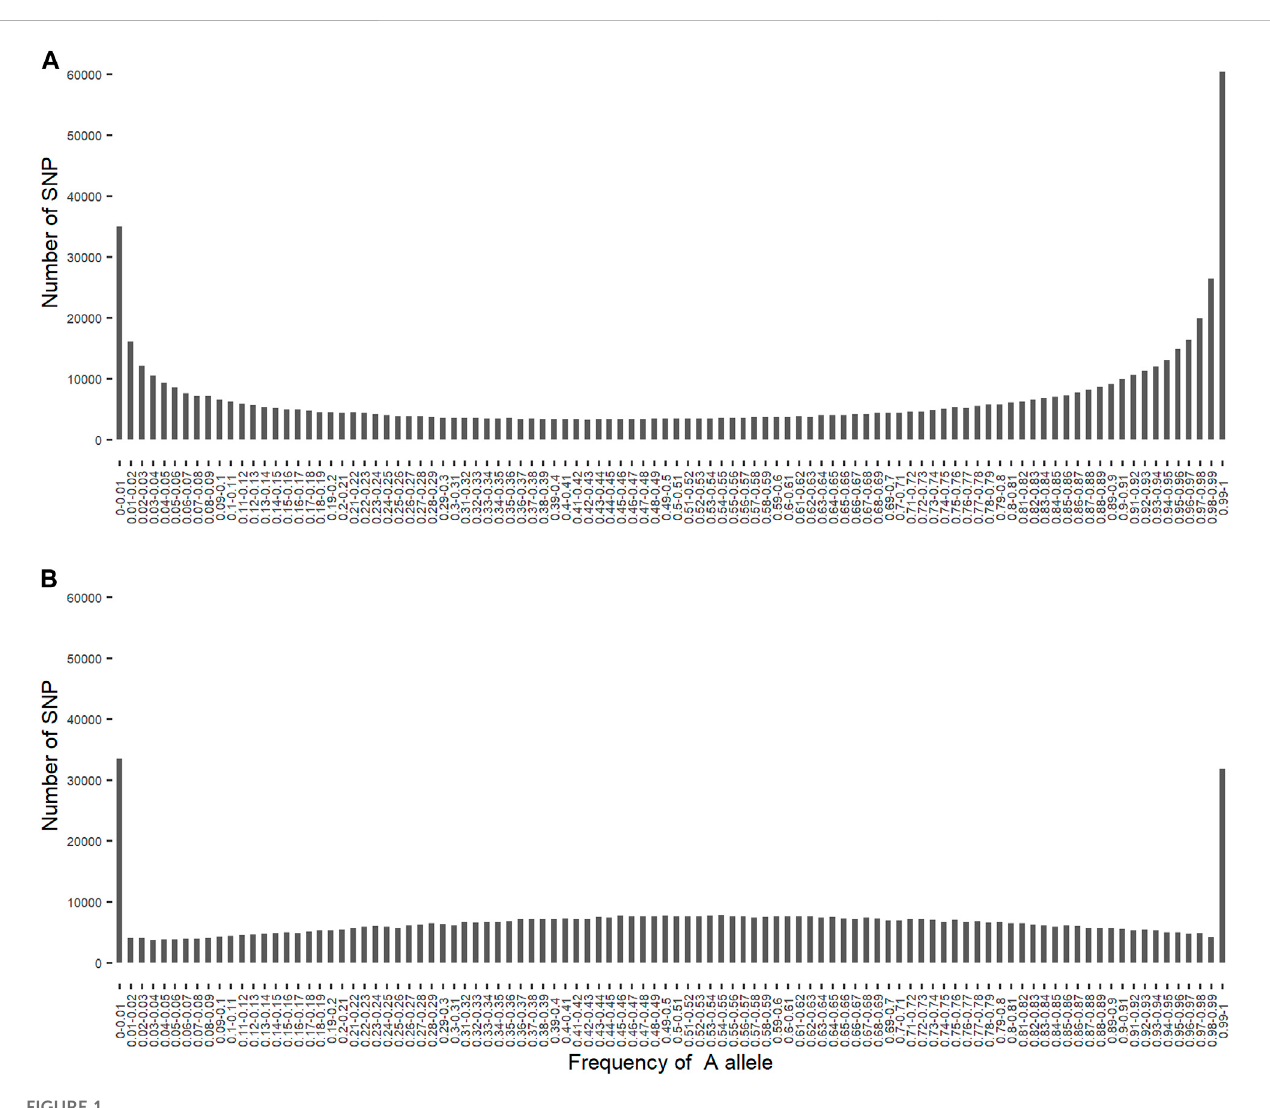
FIGURE 1 Distribution of the frequency of A allele for SNP alleles of indigenous B. indicus origin (Figure 1A) and of exotic B. taurus origin (Figure 1B).